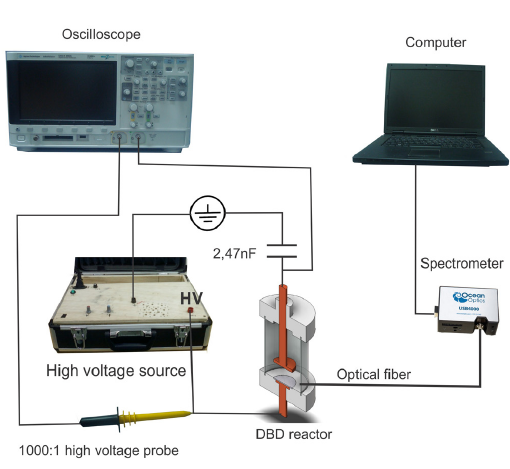
Figure 2. Experimental scheme used for electrical and optical measurements of DBD